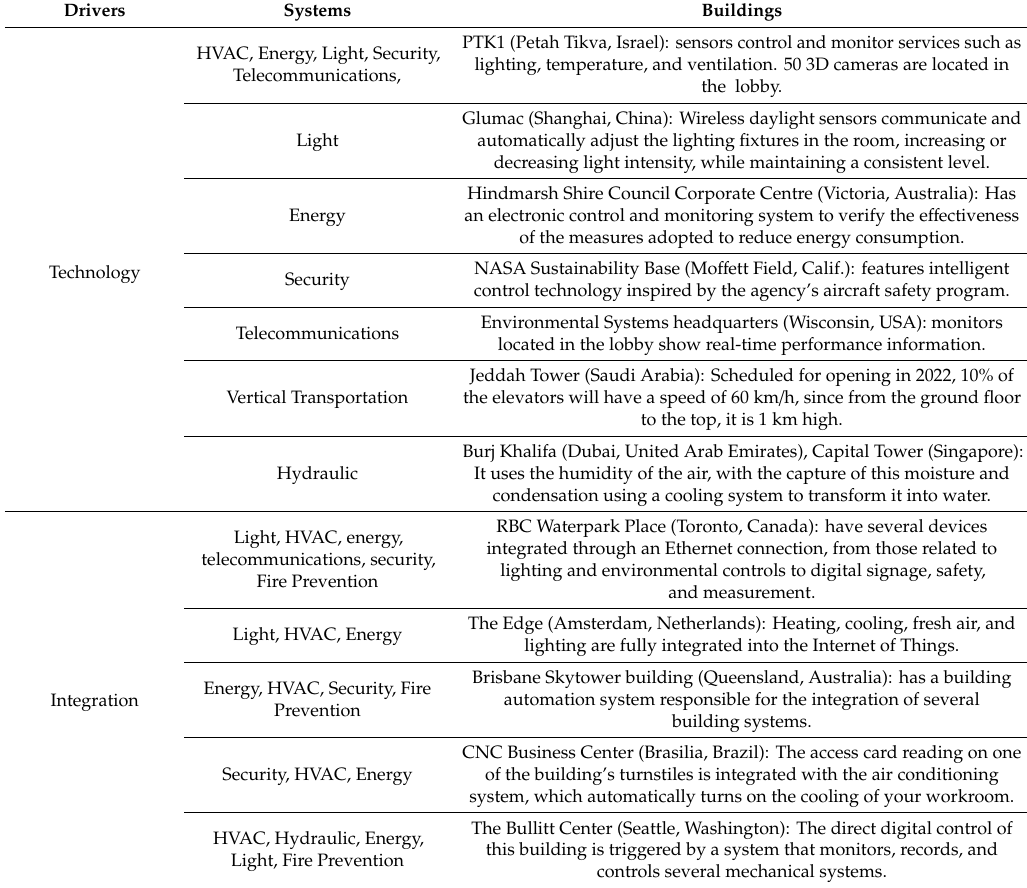
Table 4. Examples of the relationships between drivers and